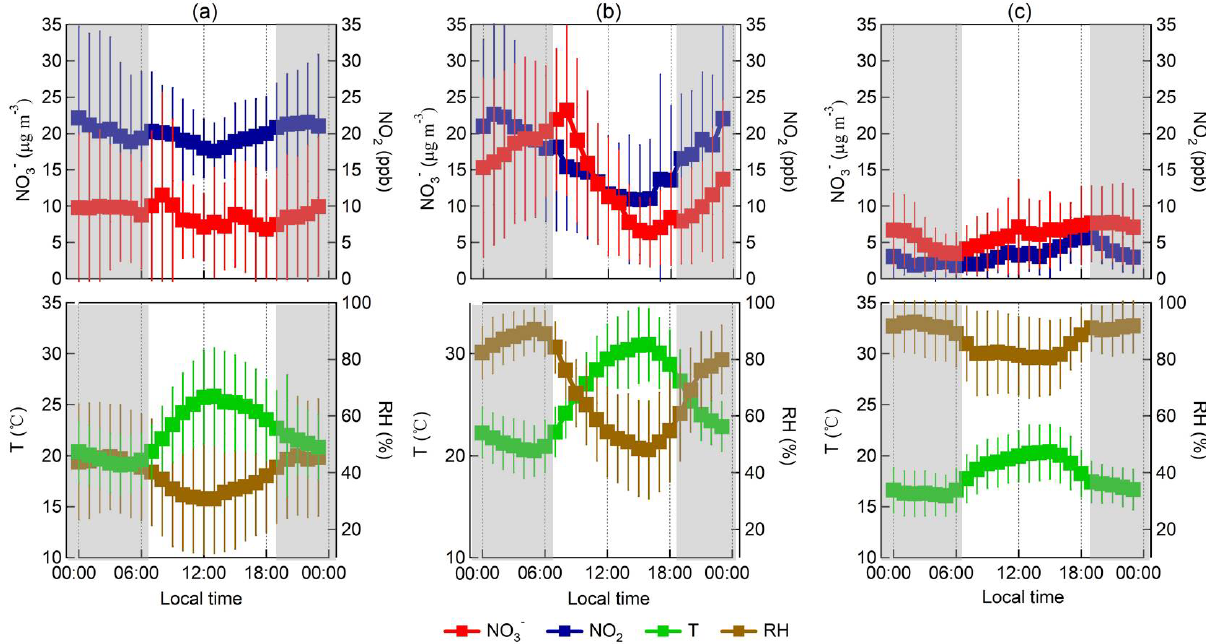
Figure 2. Average diurnal variations in fine particulate NO − , NO 2 and meteorological conditions in (a) urban Jinan in May 2014, (b) rural 3 Yucheng and (c) Mt. Tai. Error bars stand for the standard deviation of the measurements. The shaded area denotes the nighttime